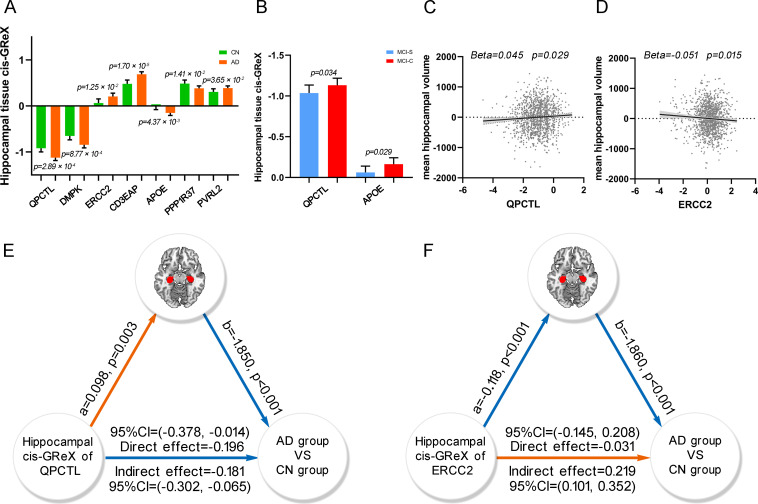
ADNI neuroimaging data analysis.(A) The bar plot shows the significant difference of hippocampal tissue cis-GReX of QPCTL, DMPK, ERCC2, CD3EAP, APOE, PPP1R37 and PVRL2 between AD and CN groups. The p-values are calculated by binary logistic regression between the hippocampal tissue cis-GReX of the seven genes and diagnoses. (B) The bar plot shows the significant difference of hippocampal tissue cis-GReX of QPCTL and APOE between MCI-C and MCI-S groups. (C and D) The scatter plots show correlations between the hippocampal tissue cis-GReX of QPCTL (C), ERCC2 (D) and mean hippocampal volume using linear regression. The y-axis shows the residual of mean hippocampal volume after regressed age, sex, education, MR field strength, first 4 components of MDS and clinical diagnoses. (E and F) The mediation analysis shows that hippocampal volume mediates the effect of the hippocampal tissue cis-GReX of QPCTL (E) and ERCC2 (F) on the diagnosis of AD. The colors of the lines demonstrate the positive correlation (orange color) and the negative correlation (blue color) in the analysis. AD, Alzheimer’s disease; cis-GReX, cis-genetically regulated expression; CN, cognitively normal; MCI-C, mild cognitive impairment conversion; MCI-S, mild cognitive impairment stable; MDS, multidimensional scaling.